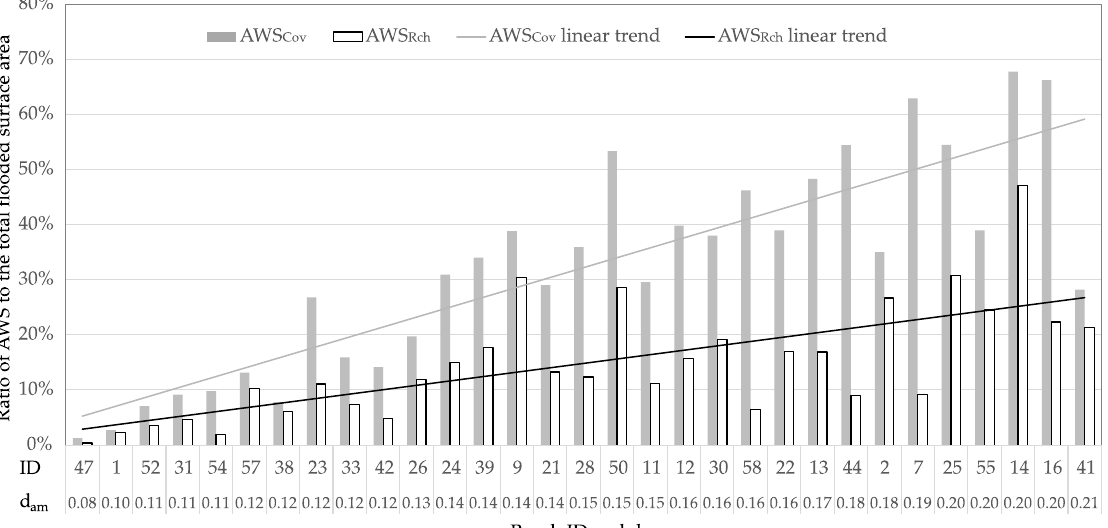
Figure 6. Comparison of ratio of AWS Cov and AWS Rch to the total flooded surface area: the reaches are arranged according to d am from 0.08 m to 0.21 m.